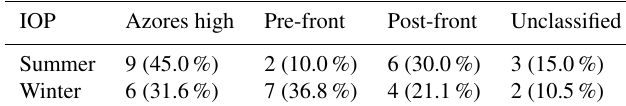
Table 4. Number of flight days under different synoptic conditions during the summer IOP and winter IOP. The corresponding percentages over the IOP are shown in the parentheses.